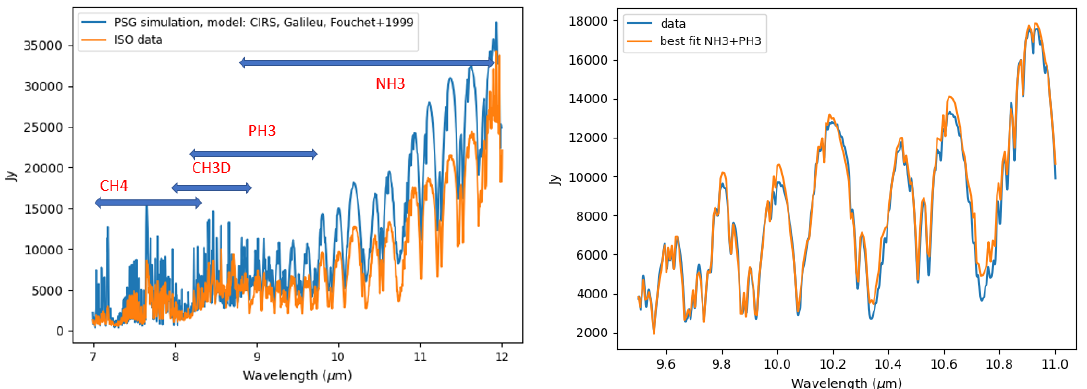
Figure 18. ( Left panel ) Comparison between the simulated Jovian spectrum using the NEMESIS CIRS model and the observational data from ISO ([54]) as input. Several molecular bands are identified in the figure. The simulation is over-predicting the data. To correct this, the vertical abundance profile of the molecules highlighted in the figure were adjusted; ( Right panel ) best-fit simulation for the PH 3 and NH 3 absorption at 9–11 µ